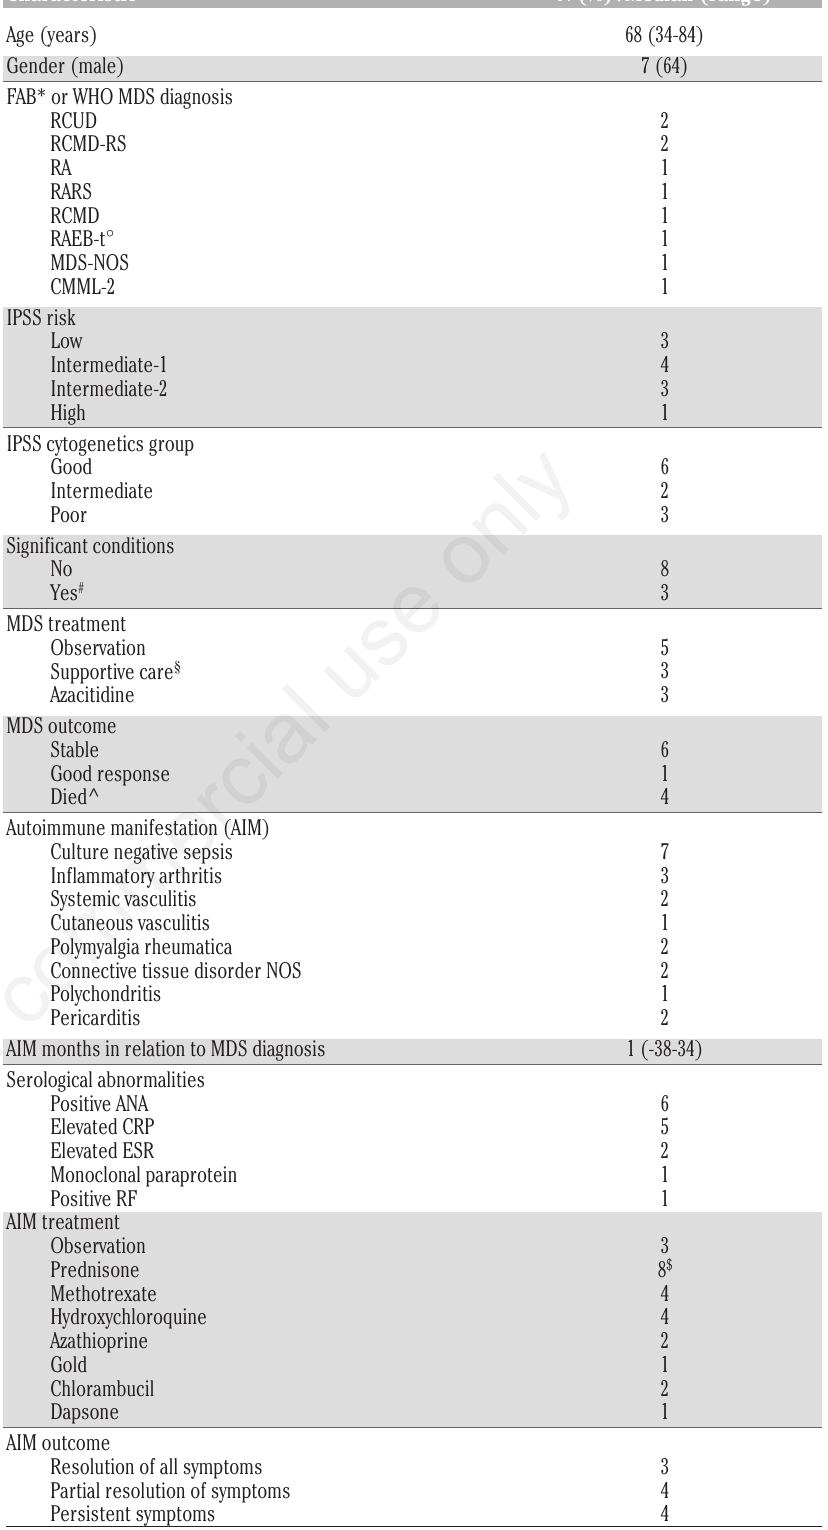
Table 1. Autoimmune manifestations of myelodysplastic syndromes in 11 patients: clini- cal features, treatment and outcome.